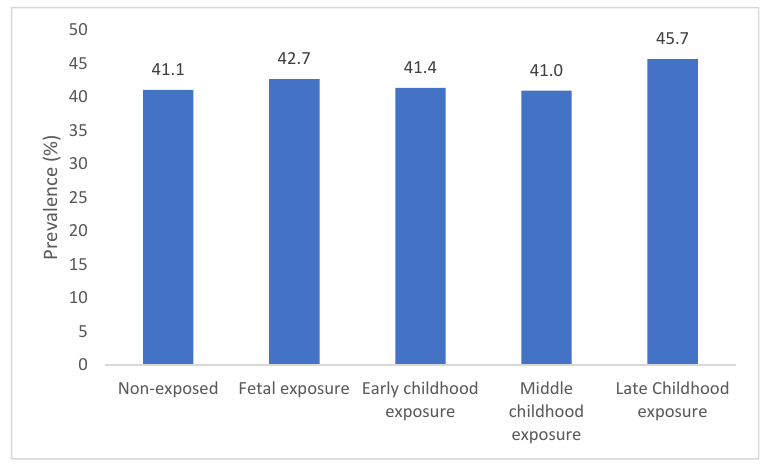
Figure 1. Prevalence of MetS.